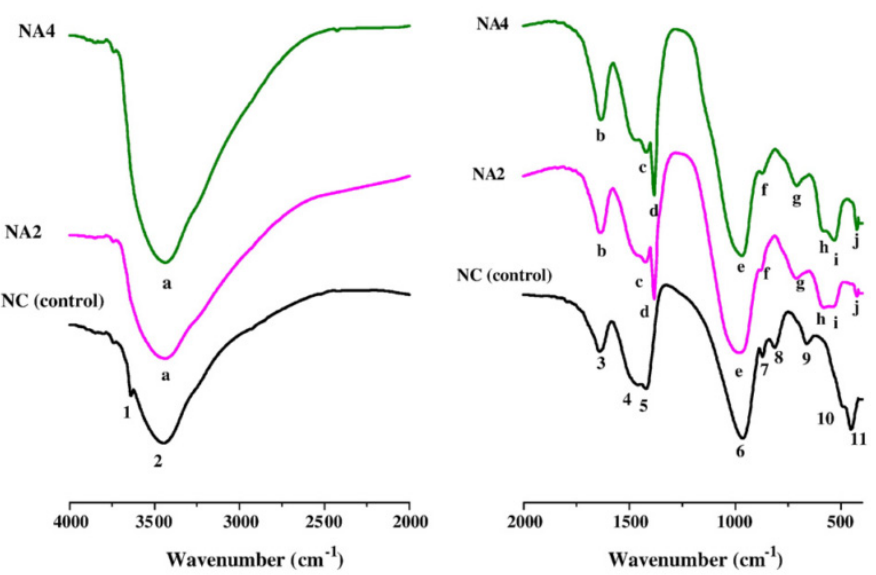
Figure 10. The role of aluminum in the asymmetric stretching of Si-O-T (in NC, NA2, and NA4 containing Al(NO 3 ) 3 ). From Elsevier Ref. [65] and used with permission.